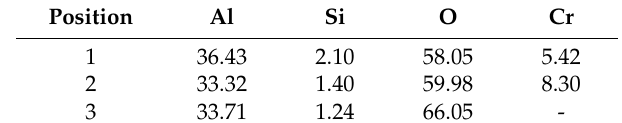
Figure 11. Macroscopical photos and cross-sectional SEM images of as-casted DZ22B alloy blades. ( a ) Blade photo (facecoat: fused alumina); ( b ) interfacial area image (facecoat: fused alumina). Table 4. EDS analysis of the points in Figure 10b (at.%).